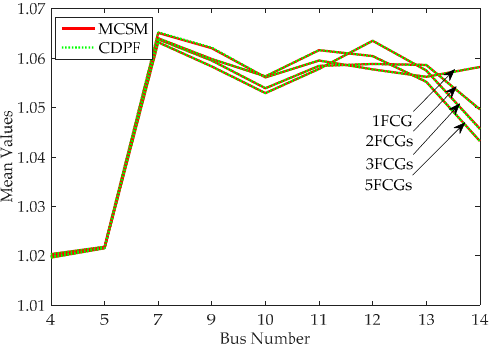
Figure 10. The means of the voltage magnitude at PQ buses with one, two, three and five FCGs, respectively, at different buses in an IEEE 14-bus power system.